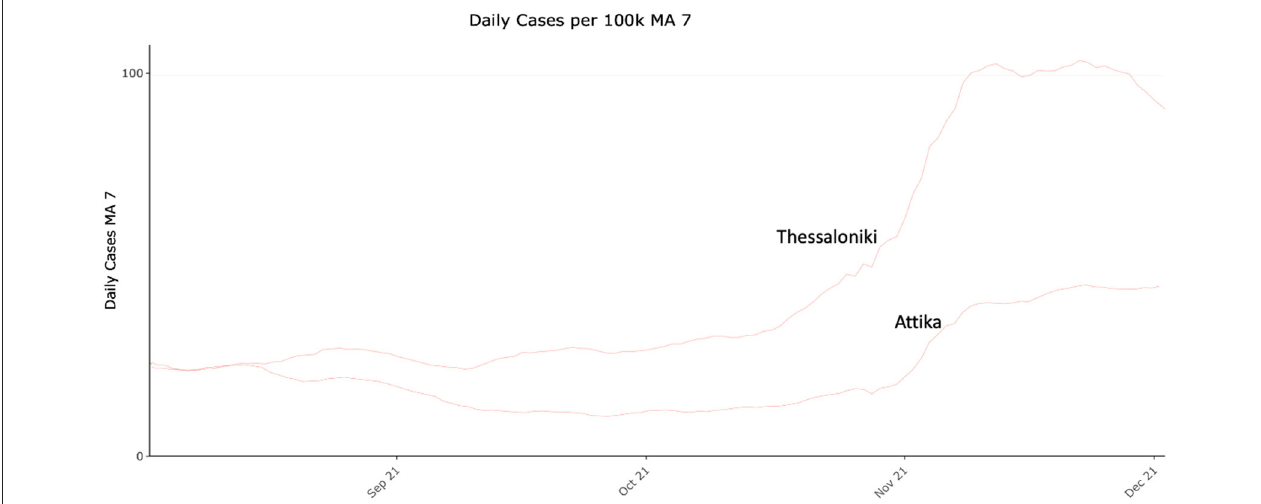
FIGURE 6 | COVID-19 daily cases (7-day moving average) per 100.000 residents in Attika and Thessaloniki between August and December 2021.